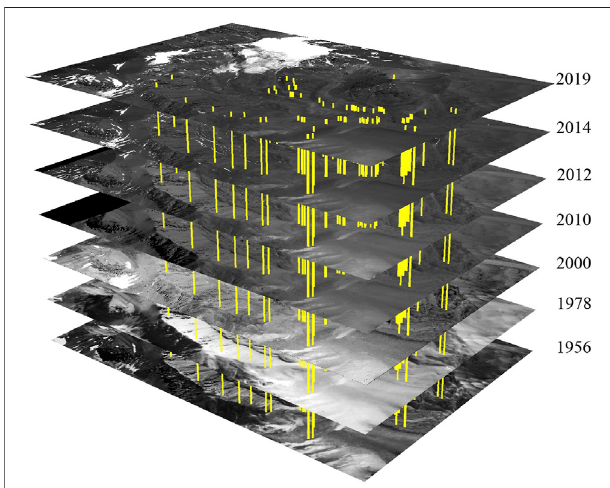
FIGURE 4 | Time-series of orthorecti fi ed aerial and satellite images between 1956 and 2019. Yellow lines represent the stable points outside the moving landforms employed for CIAS